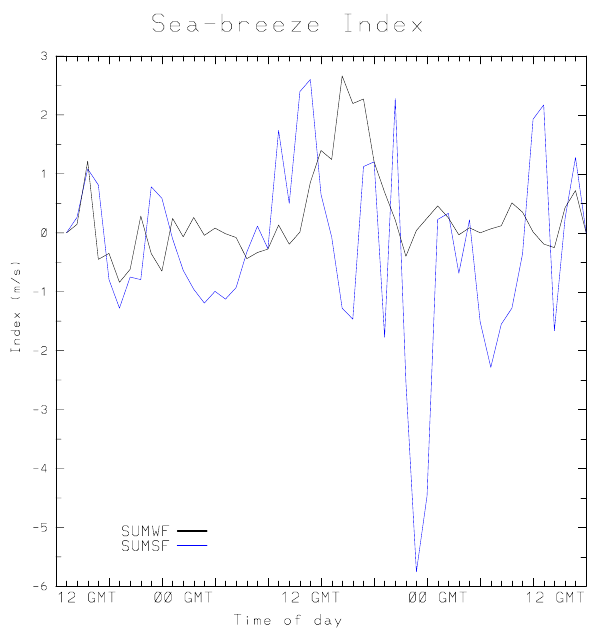
Fig. 6. Time evolution of sea-breeze index (see Eq. 1) for the SUMWF (black line) and SUMSF (blue line) cases. Units are